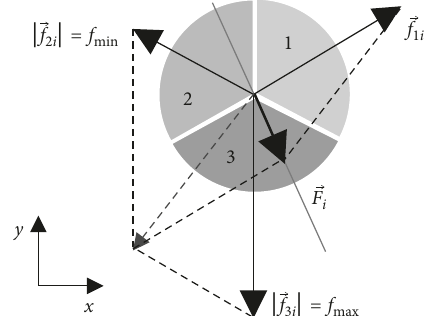
Figure 8: Orientation of the forces in the xy plane.